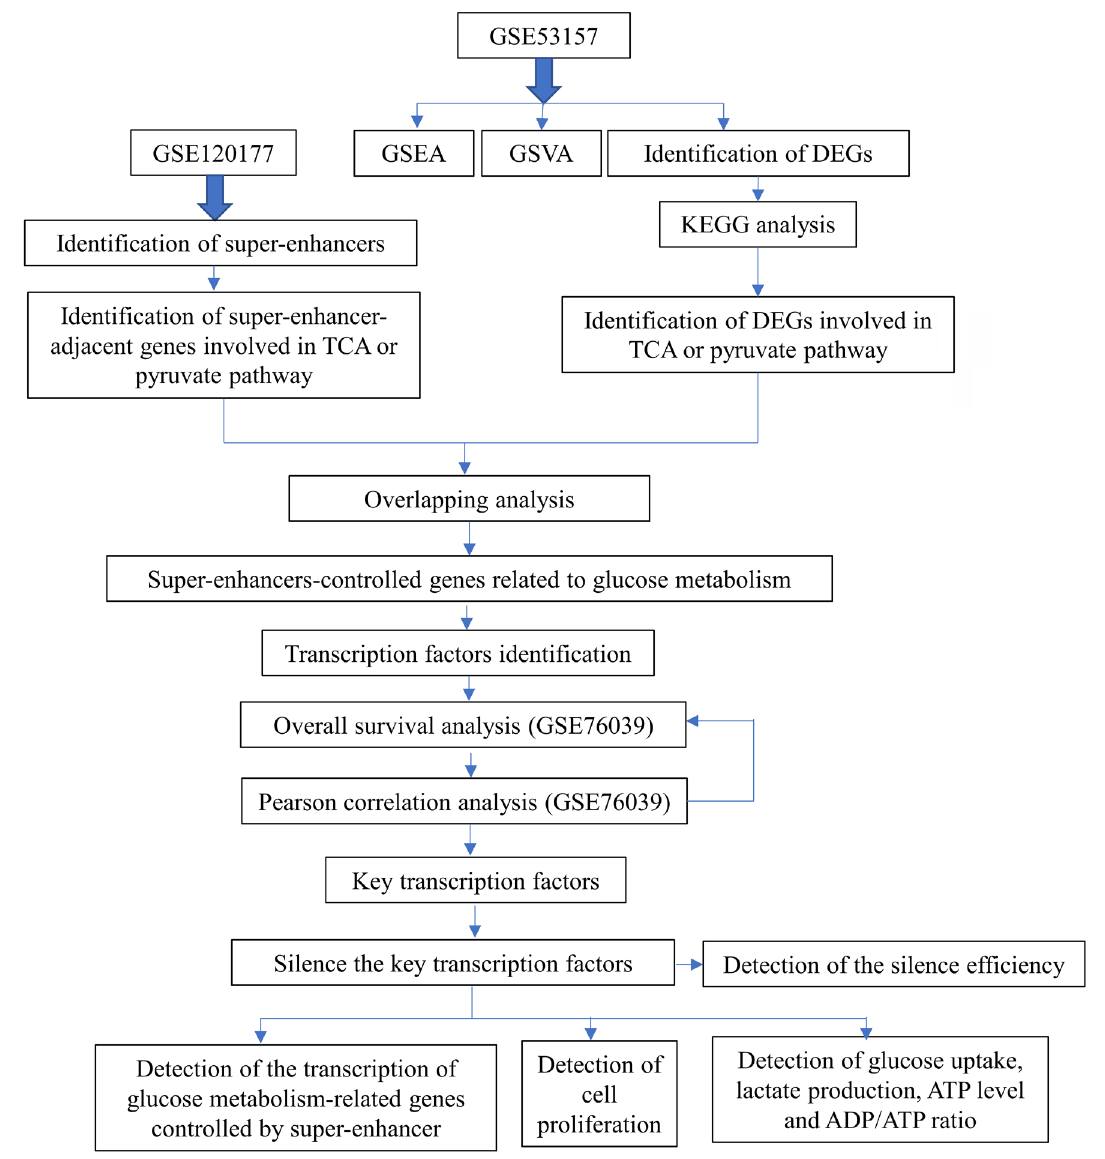
Figure 1. Flowchart of the research